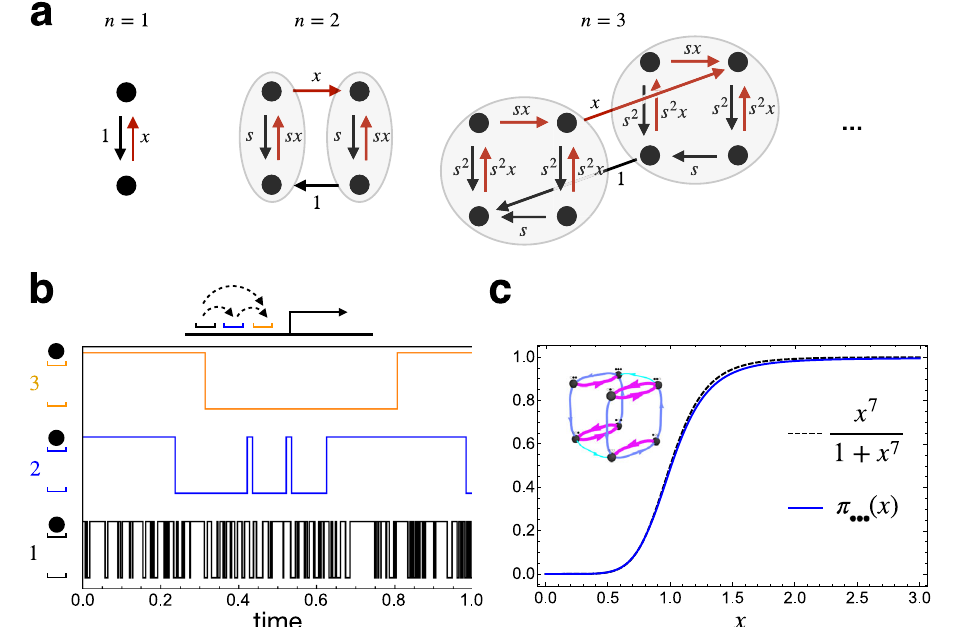
Fig. 4 | Nested hysteresis.a Iterative construction of the kineticscheme of nested hysteresis, generalizable to any value of n . In each diagram, the gray ovals indicate the subsystems (corresponding to binding and unbinding to the fi rst n − 1 sites), which are assumed to relax much faster than the other transitions. b Occupation over time for each of n =3 binding sites (black, blue, and orange), in a particular